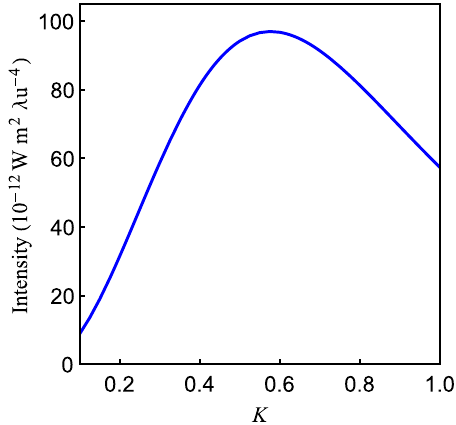
FIG. 7. Circular polarization: For a single electron the on-axis intensity of the fundamental harmonic H 1 versus K at a distance of 100 λ u . The electron energy is 60